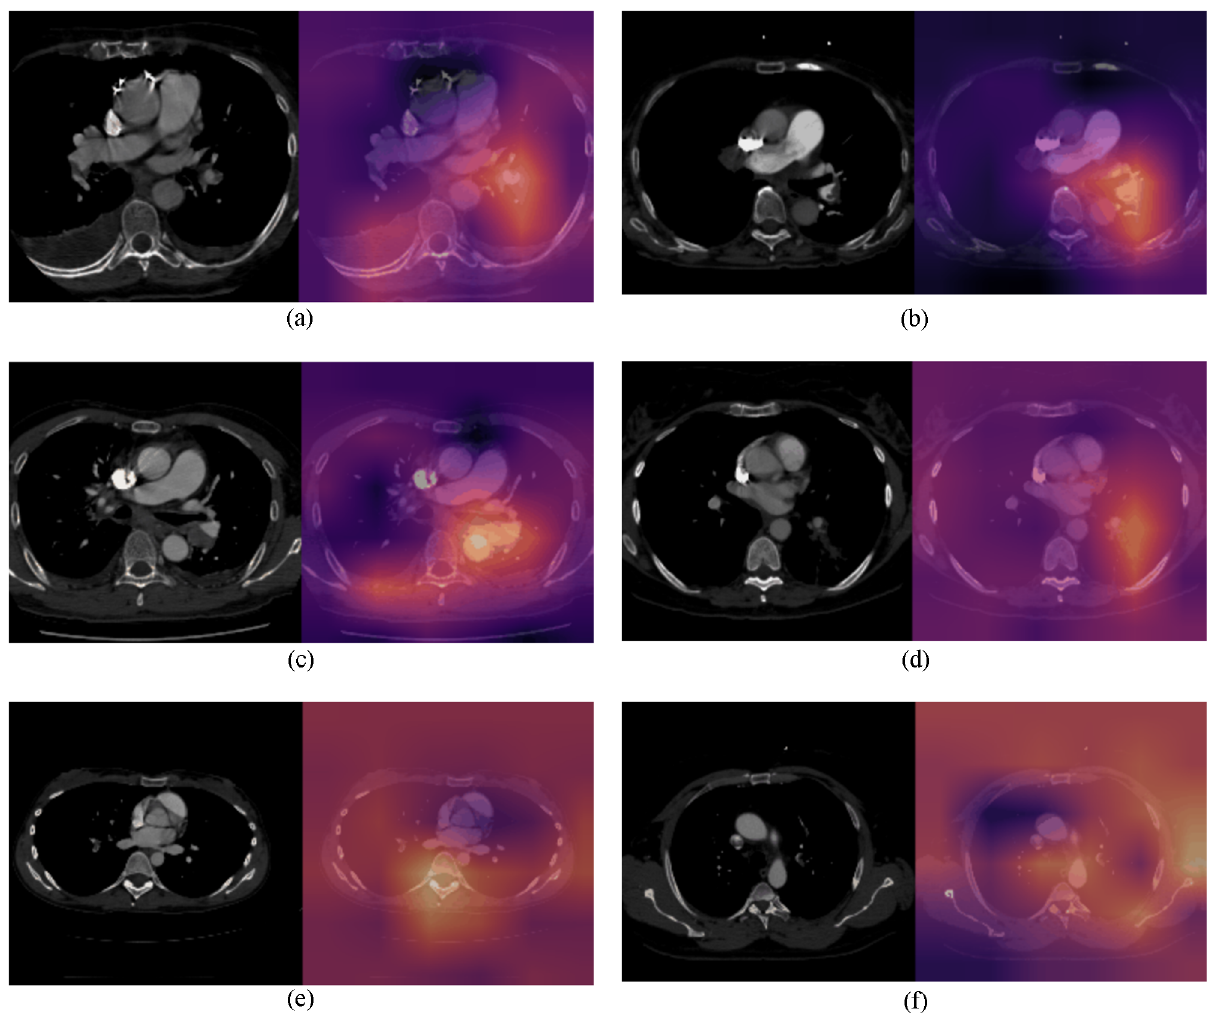
Fig. 3 (Class Activation Maps): Class activation map (CAM) representation of true positive (Stanford ( a ) and Intermountain ( b ), false-positive (Stanford ( c ) and Intermountain ( d ) and false-negative samples (Stanford ( e ) and Intermountain ( f ) — axial contrast enhanced CT pulmonary angiogram (left) and CAM inferred by the model overlay with the scan (right). a (Stanford test set: true positive): (left) demonstrates a non- occlusive fi lling defect in a left lower pulmonary artery segmental branch that is correctly localized by the model as seen in the CAM image overlay (right). b (Intermountain test set: True Positive): (left) demonstrates a non-occlusive fi lling defect in a left main pulmonary artery that is correctly localized by the model as seen in the CAM image overlay (right). c (Stanford test set: false positive): left) demonstrates a large left hilar node adjacent to the pulmonary artery that is incorrectly labeled as PE by the model as seen in the CAM image overlay (right). d (Intermountain test set: false positive): (left) demonstrates an enlarged unopac fi ed left lower lobe pulmonary vein invaded by tumor that is incorrectly labeled as PE by the model as seen in the CAM image overlay (right). e (Stanford test set: false negative): (left) Pulmonary embolism in right middle lobe segmental branch that is missed by the model as seen in the CAM image overlay (right). f (Intermountain test set: False negative): (left) Pulmonary embolism in left upper lobe segmental branch that is missed by the model as seen in the CAM image overlay